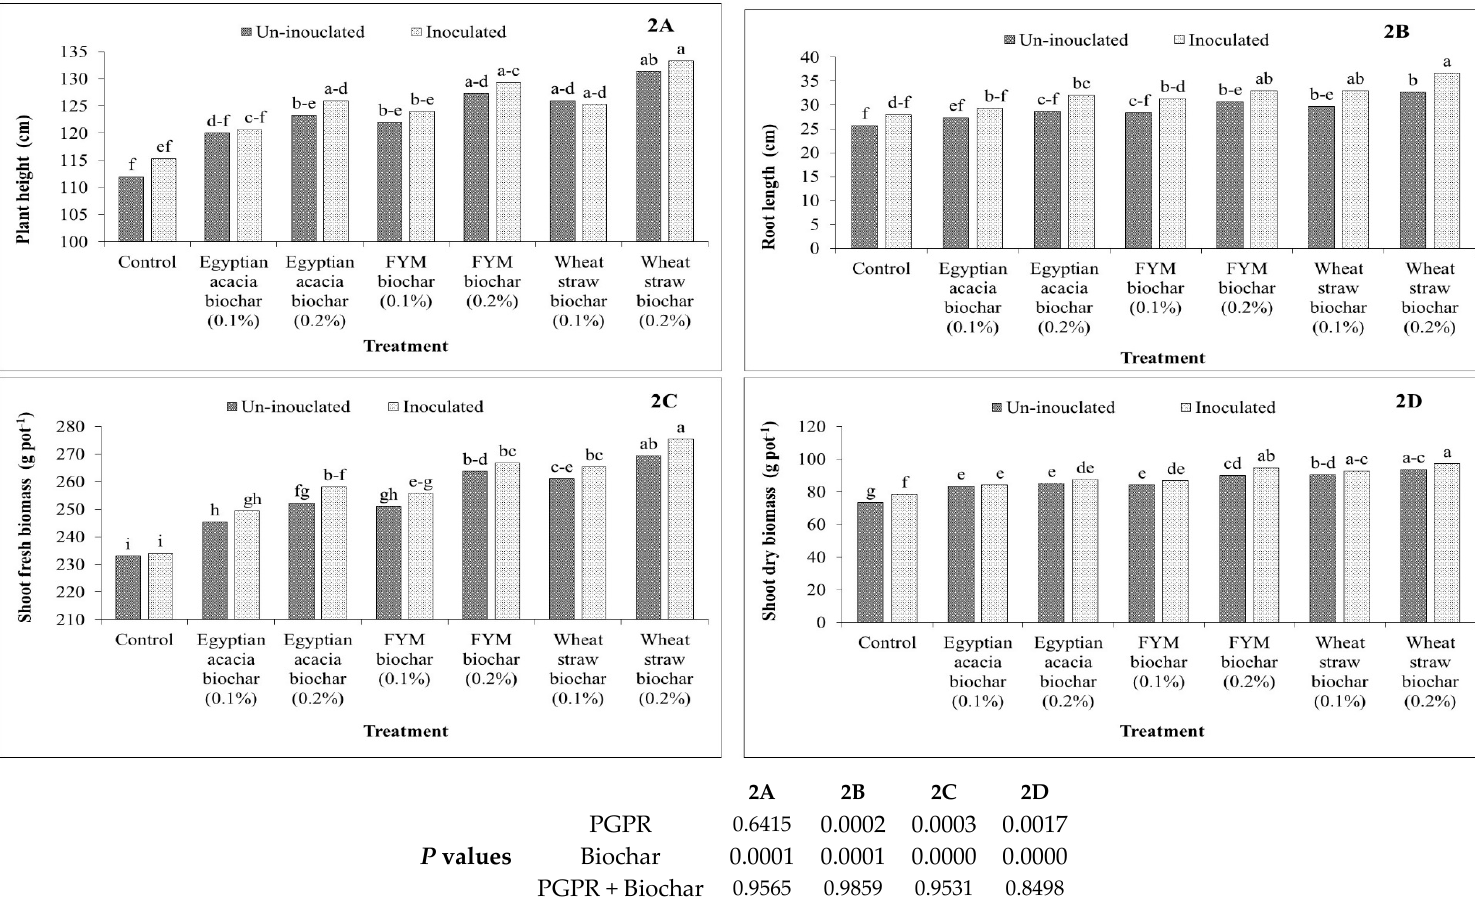
Figure 2. Effects of biochar with and without Bacillus sp. ZM20 on plant height ( A ): LSD 8.7945), root length ( B ): LSD 3.6996), shoot fresh biomass ( C ): LSD 6.8333) and shoot dry biomass ( D ): 4.6543) of maize under pot trial; (n = 3); bars sharing same letters are statistically not different from each other at p ≤ 0.05.